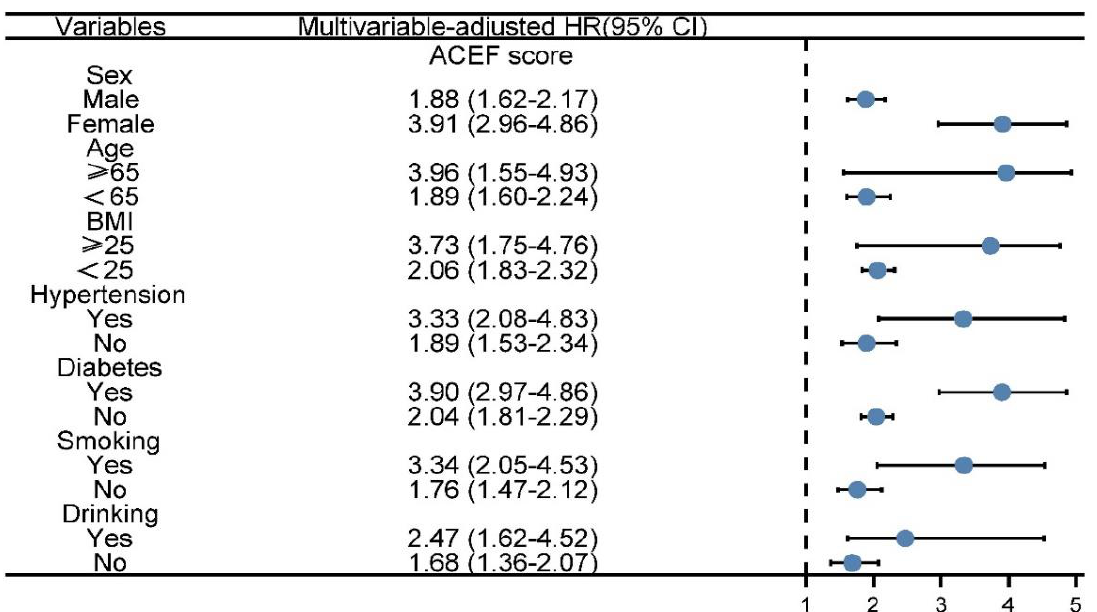
Figure 4. Multivariate adjusted subgroup analysis of ACEF score in relation to CVD. Adjusted for sex, BMI, drinking, smoking, TCH, TG, diabetes, hypertension, LDL-c, TCH, and TG. SD, standard deviation.